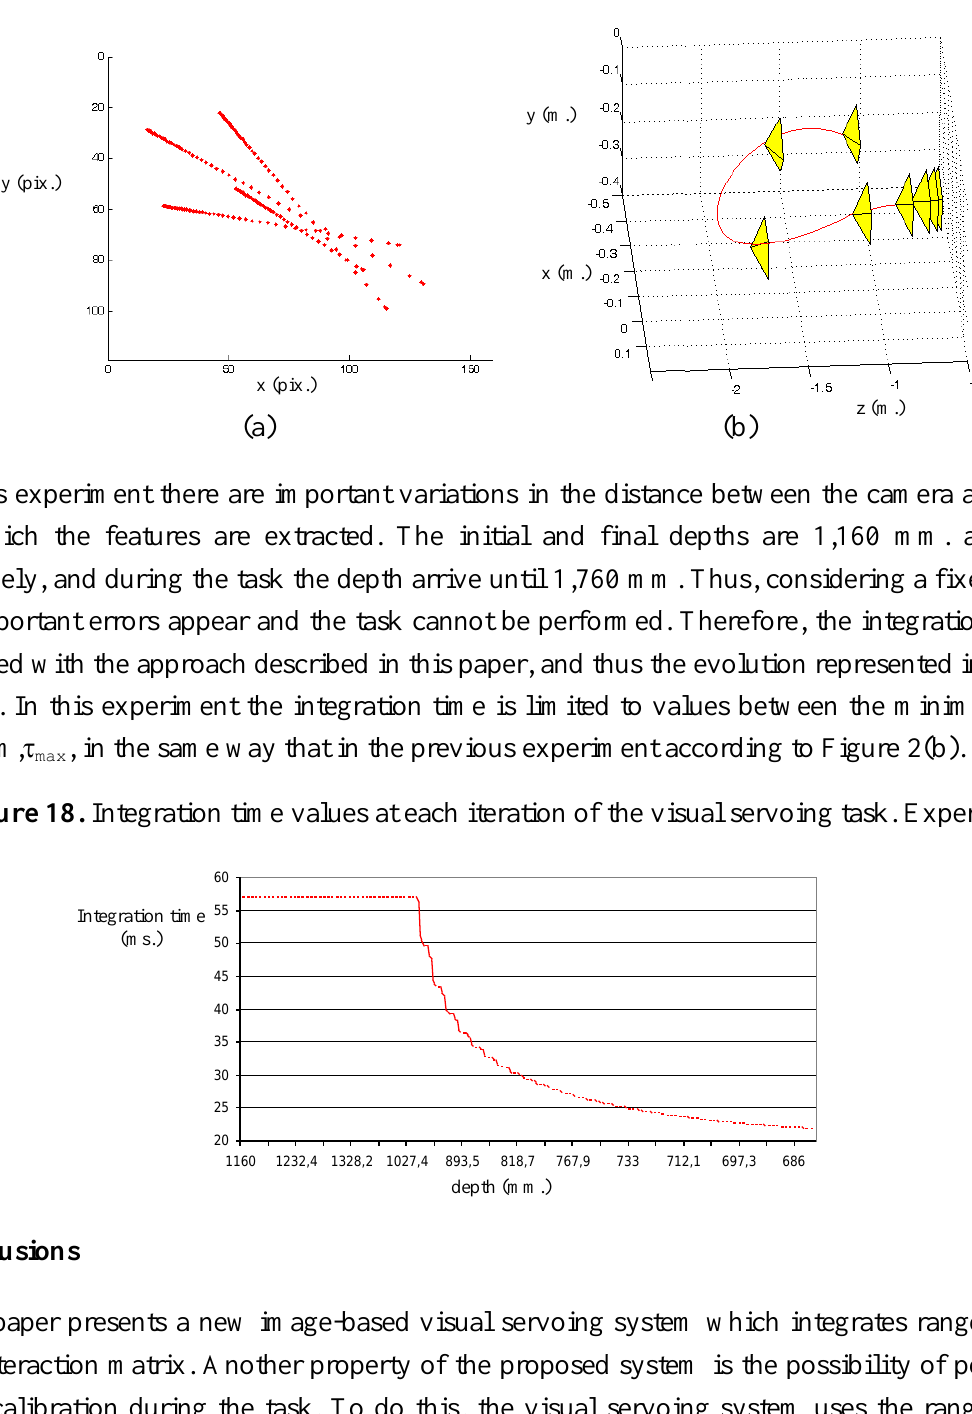
Figure 17. Trajectory during the visual servoing task. (a) Trajectory of the image features. (b) Trajectory of the eye-in-hand camera. Experiment 3.